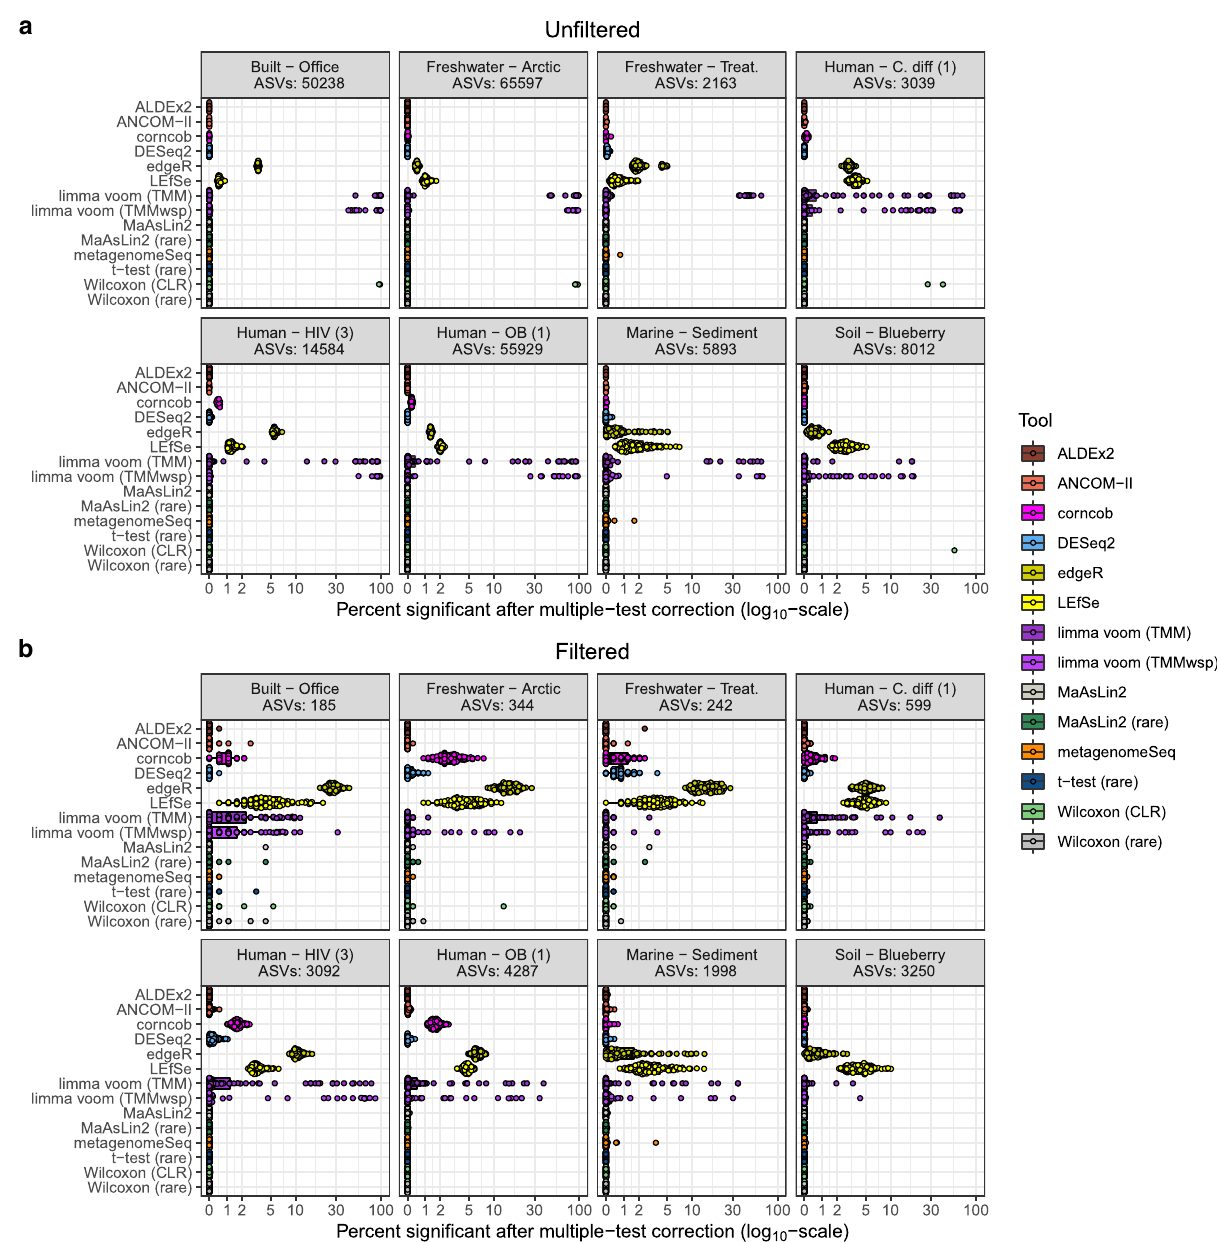
Fig. 4 Distribution of false discovery rate simulation replicates for both un fi ltered and fi ltered data. The percentage of amplicon sequence variants that are signi fi cant after performing Benjamini – Hochberg correction of the p -values (using a cut-off of 0.05) are shown for each separate dataset and tool. Interquartile range (IQR) of boxplots represent the 25 th and 75 th percentiles while maxima and minima represent the maximum and minimum values outside 1.5 times the IQR. Notch in the middle of the boxplot represent the median. Note that the x -axis is on a pseudo-log 10 scale. a Represents un fi ltered datasets while b represents datasets fi ltered using a 10% prevalence requirement for each ASV. Datasets and tools were run 100 times while randomly assigning samples from the same environment and original groupings to one of two new randomly selected groupings. Differential abundance analysis was then performed on the two random groupings. Note that in the un fi ltered datasets 100 replicates was only run 3 of the 8 datasets (Freshwater — Arctic, Soil — Blueberry, Human — OB (1)) with 100 ALDEx2 replications also being run in the Human - HIV (3) dataset. All other un fi ltered datasets were run with 10 replicates due to computational limitations. Abbreviations: TMM, trimmed mean of M-values; TMMwsp, trimmed mean of M-values with singleton pairing; rare, rare fi ed; CLR, center-log-ratio. Source data are provided as a Source Data fi